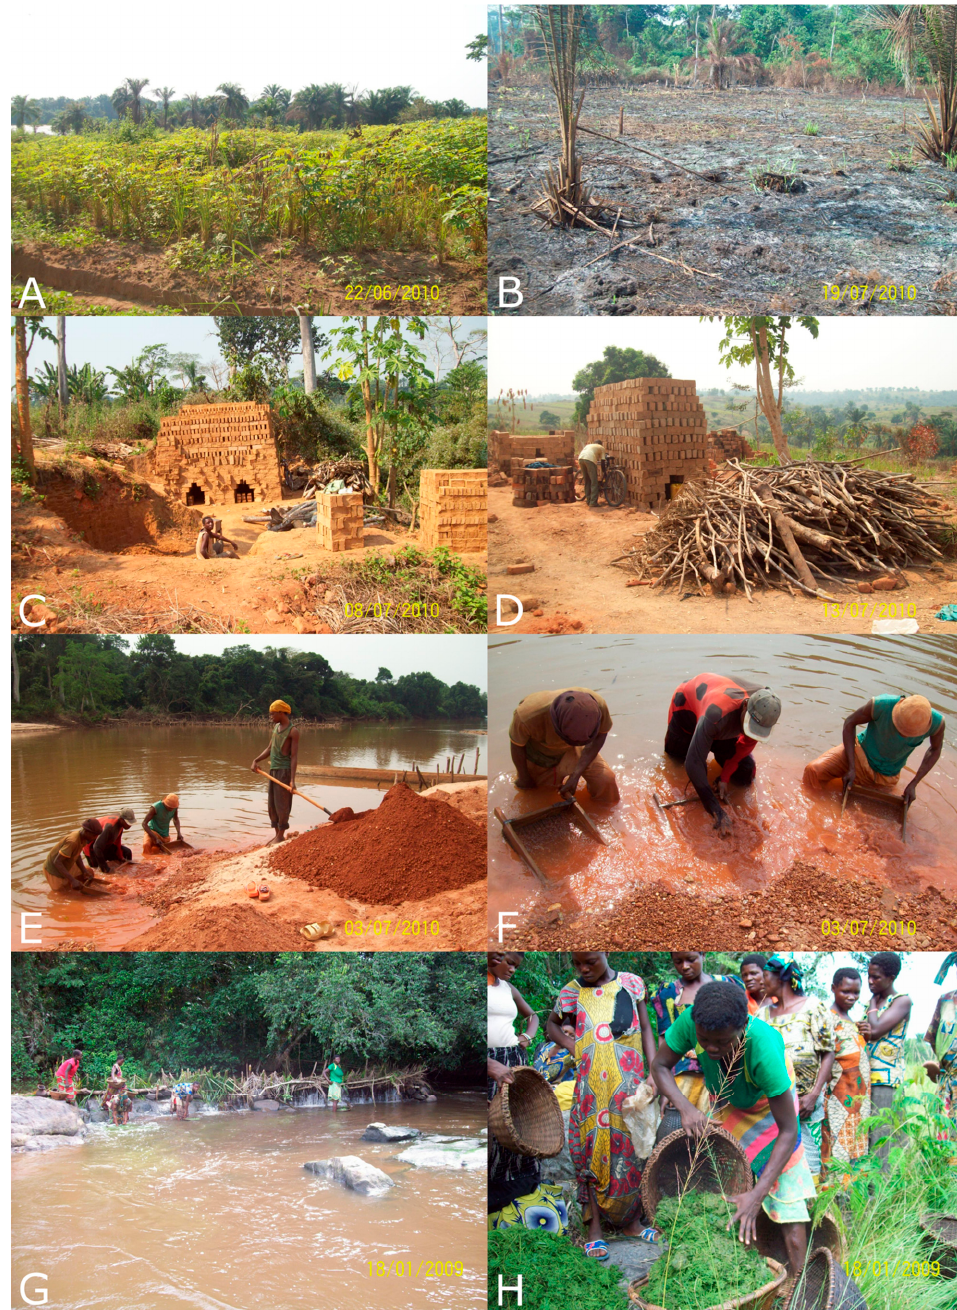
Figure A7. Selected images of some human activities with direct and indirect impacts on the ichthyofauna of the LR. ( A , B ) Shifting agriculture, ( C , D ) Brick fabrication and clay mining, ( E , F ) Artisanal diamond mining, ( G ) Dam prepared for fishing, ( H ) Vegetal ichthyocide preparation just before use in fishing.